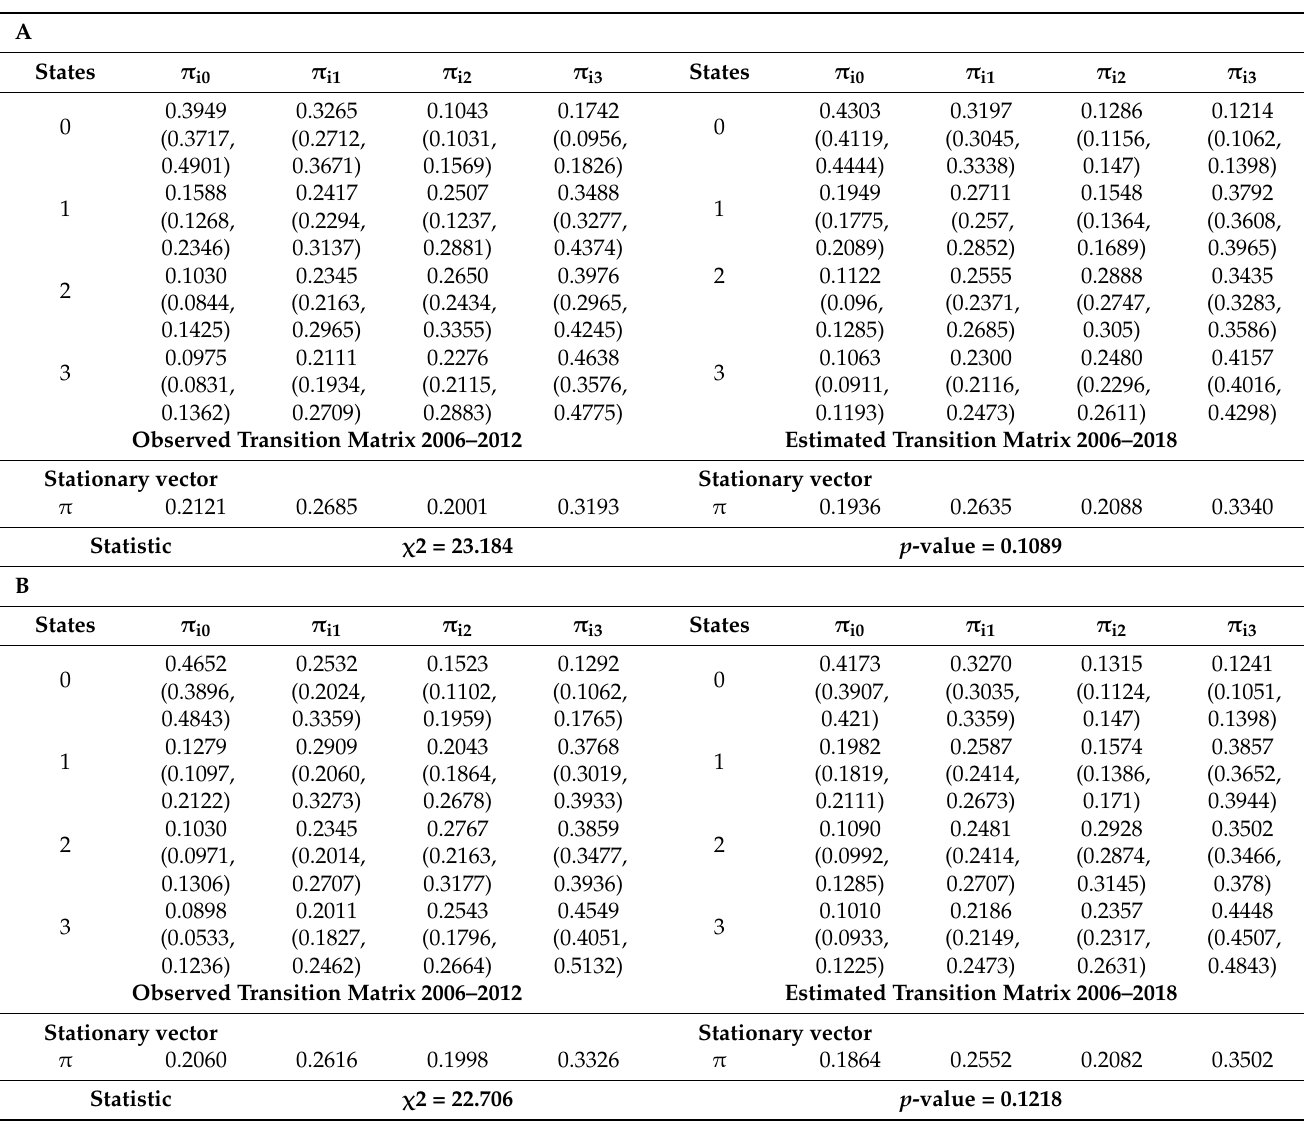
Table 5. A. Transition probabilities for Mexican people with Type 2 diabetes mellitus (DM2) (2006–2018). B. Transition probabilities for Mexican people without DM2